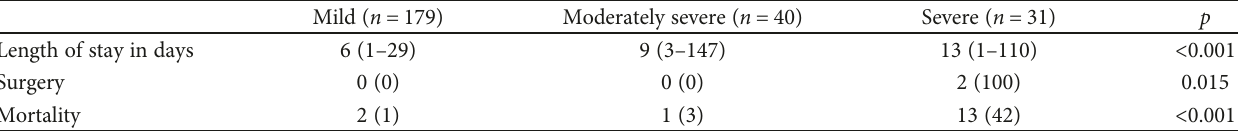
Table 6: Treatment